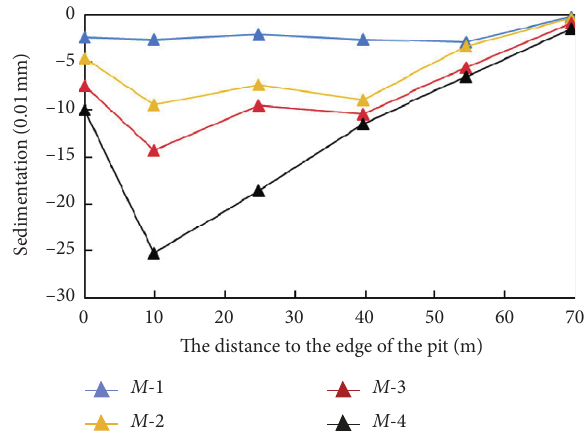
Figure 17: Soil settlement of 0.30H.